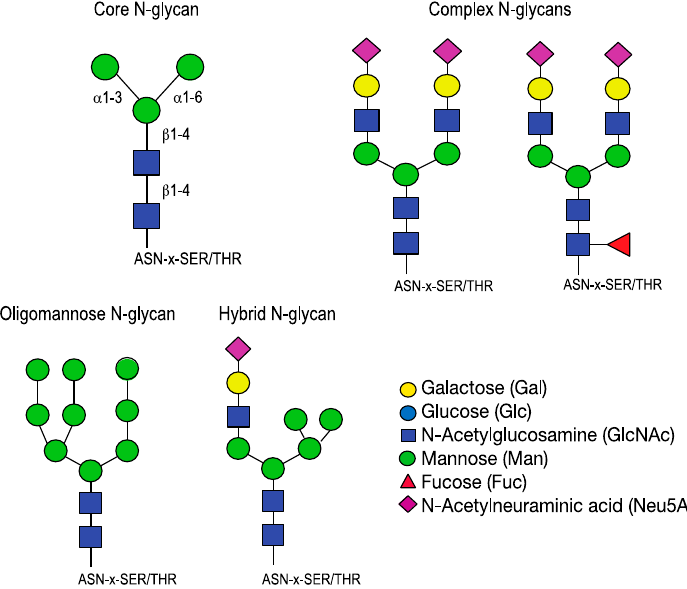
Figure 4. N -glycan core and complex structures. The core N -glycan is modified by the addition of subsequent monosaccharides to differentiate into oligomannose, complex or hybrid structures. Complex N -glycan structures relevant for IAV HA binding are shown.